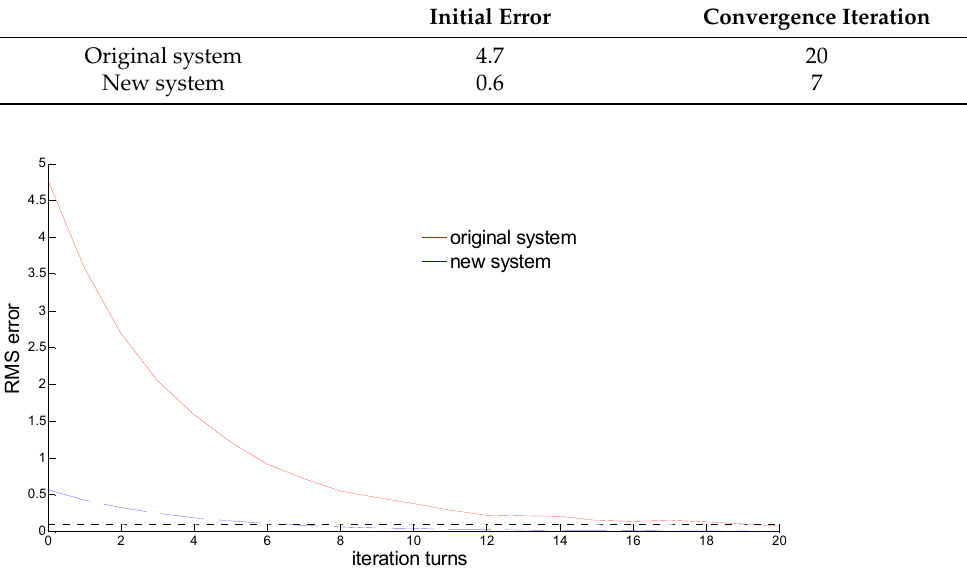
Figure 6. ILC of Translational Experience Transform.